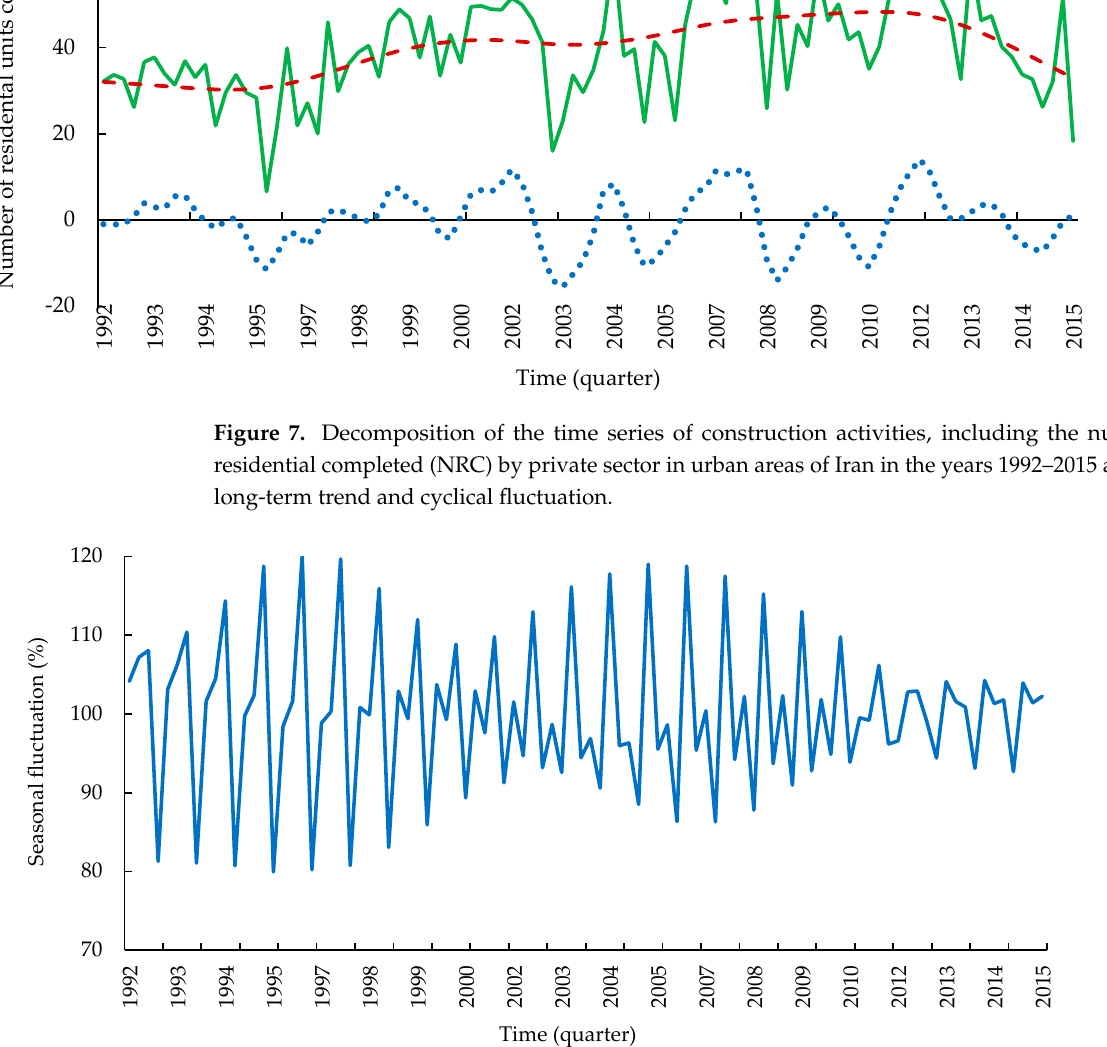
Figure 8. Decomposition of the time series of construction activities, including seasonal fluctuation indices in Hyrcanian forest in 1992–2015.